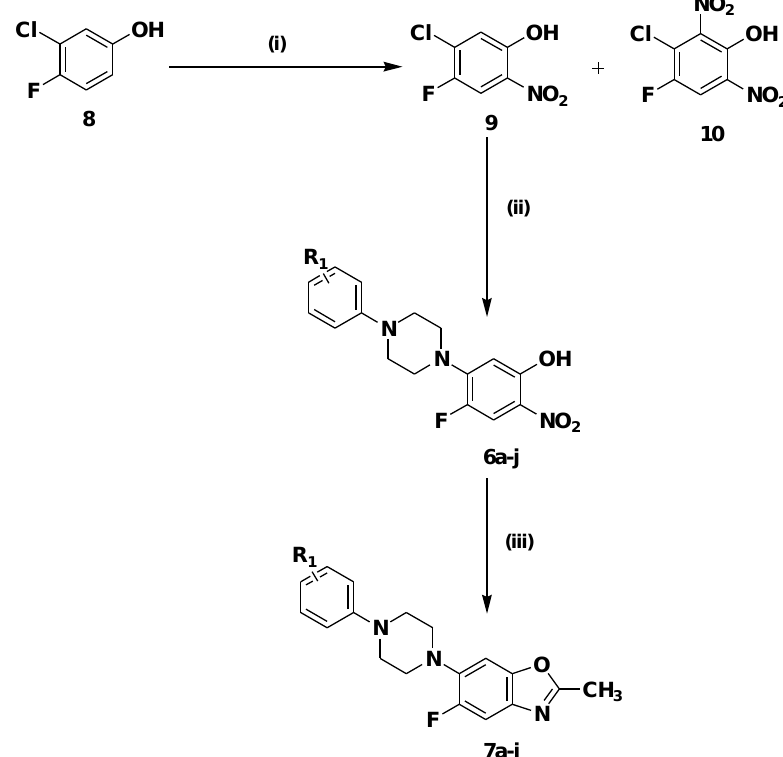
Table 1. Data for the synthesis of benzoxazoles and their